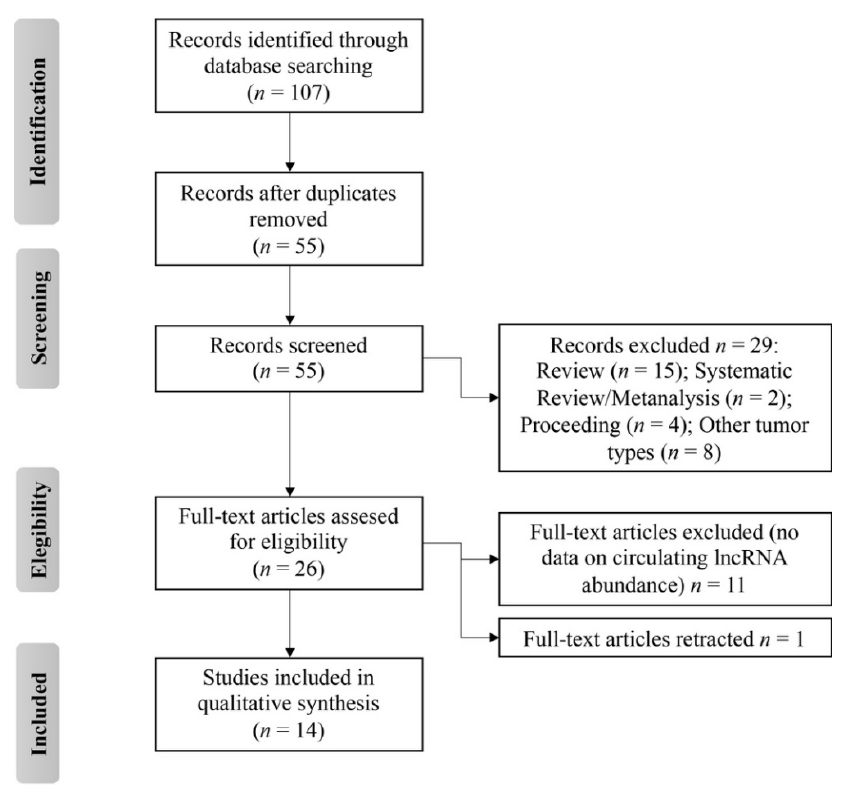
Figure 2. Flow diagram of preferred reporting items for systematic reviews and meta-analyses (PRISMA) of this systematic review. Table 1. Characteristic of the included studies.